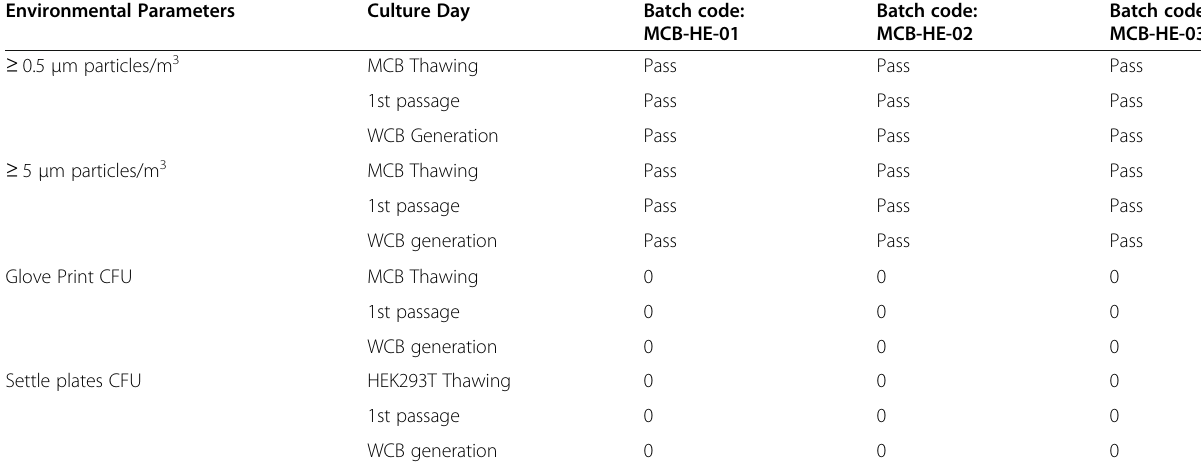
Table 3 Environmental parameters of WCB validation. Table summarizing the environmental parameters collected during the analyses of WCB batches. The concentration of airborne particles in cabinet (Grade A) was measured at each step of the procedure. Particles equal or greater than 0.5 µm met defined acceptance criteria. Particles equal or greater than 5 µm met defined acceptance criteria. Glove prints of personnel operating in the cabinet (Grade A) were sampled at each step of the procedure. No microorganisms were detected, in line with the acceptance criteria. The presence of airborne microorganisms in the cabinet (Grade A) was monitored at each step of the procedure by using settle plates. No microorganisms were detected meeting defined